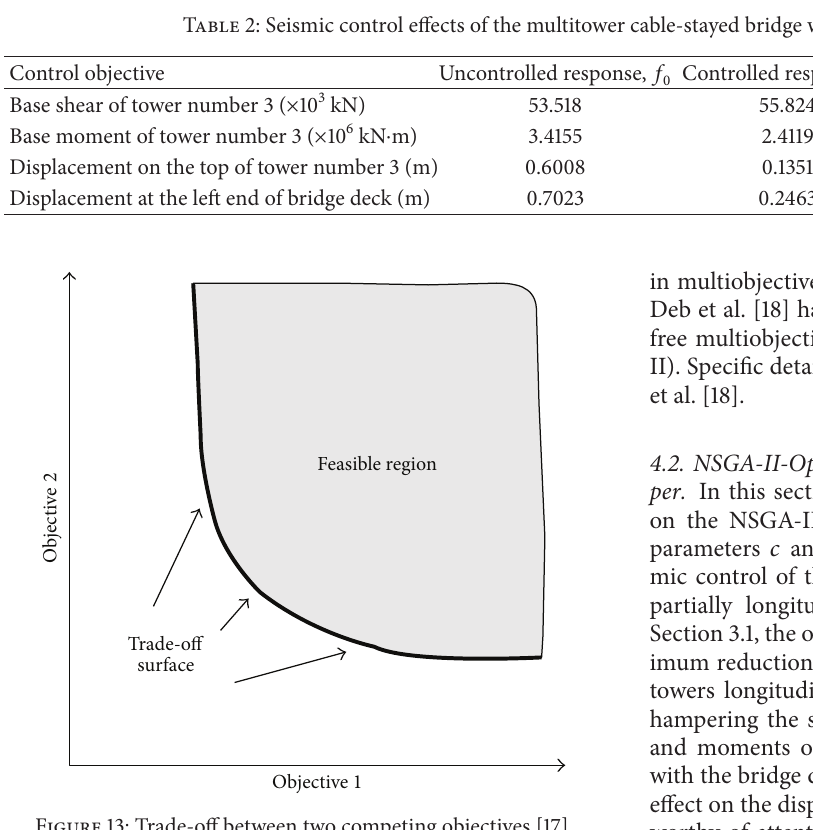
further shows the seismic control effects using the values of damping coefficient 𝑐 = 16000 and velocity exponents 𝛼 = 0.8